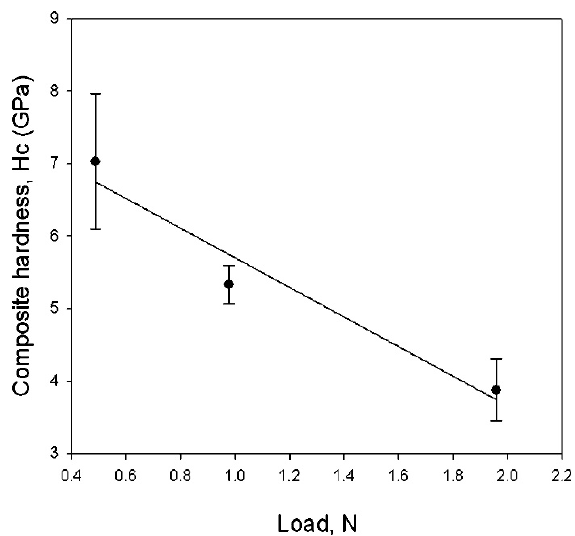
Figure 5. Composite Vickers hardness of the film/substrate (ReB 2 /SiO 2 ) system versus load. Considering the film thickness, the intrinsic hardness of the ReB 2 film was 52 ± 6 GPa. Reprinted with permission from [78]. Copyright 2008 American Chemical Society.